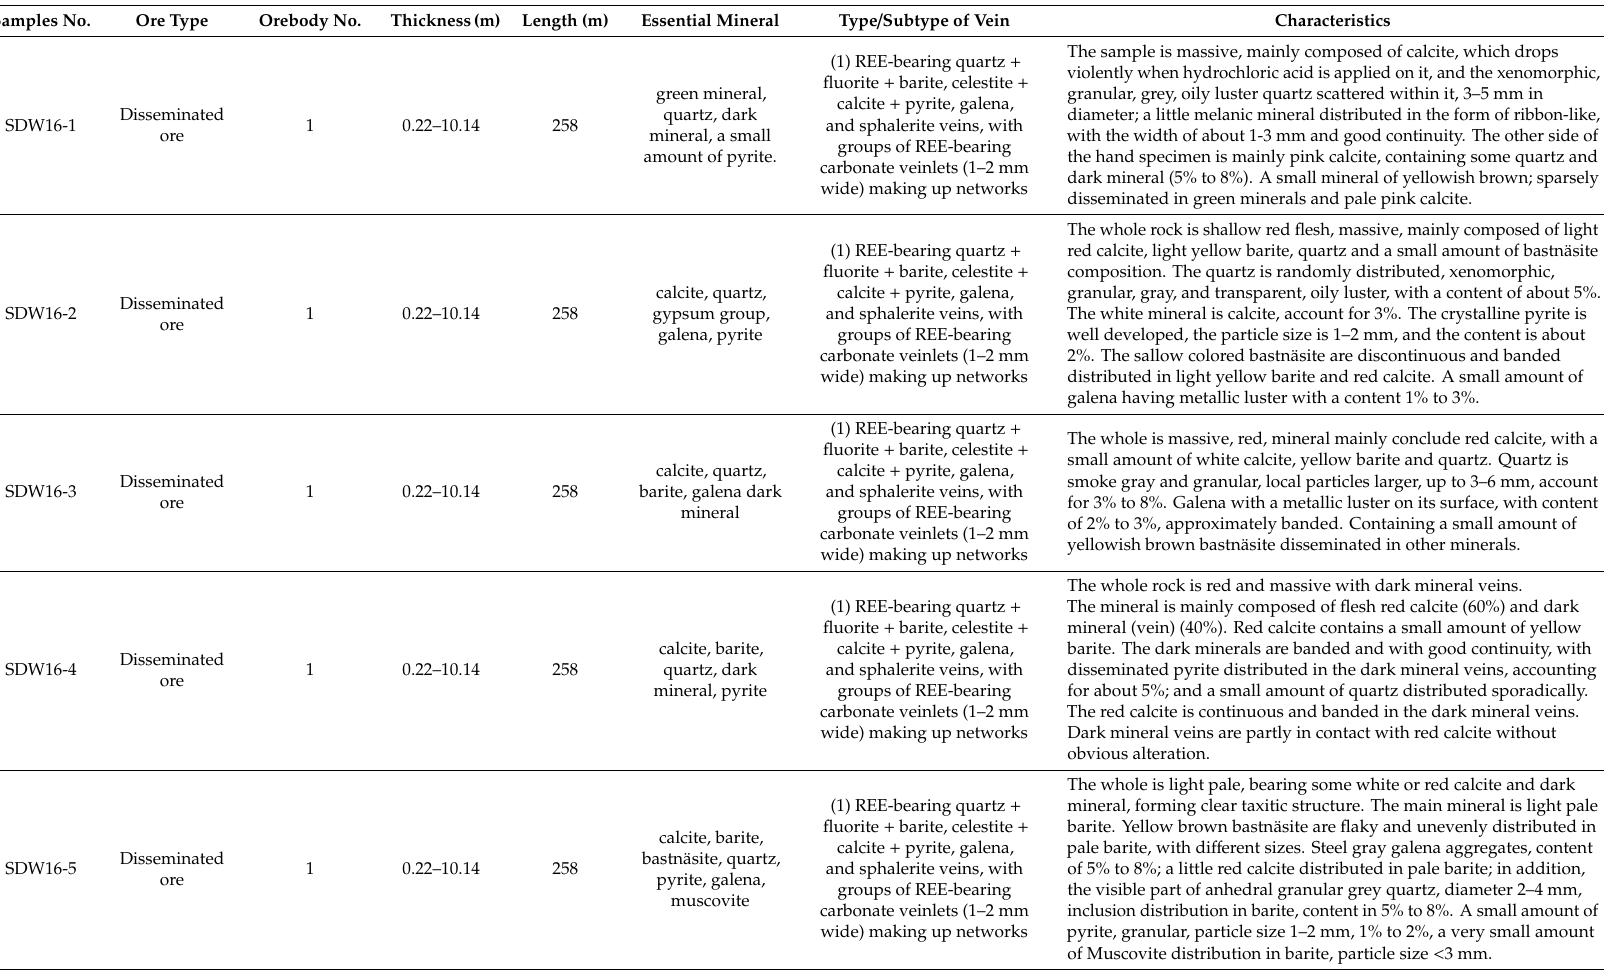
Table 2. Key features of samples from the Weishan REE deposit.